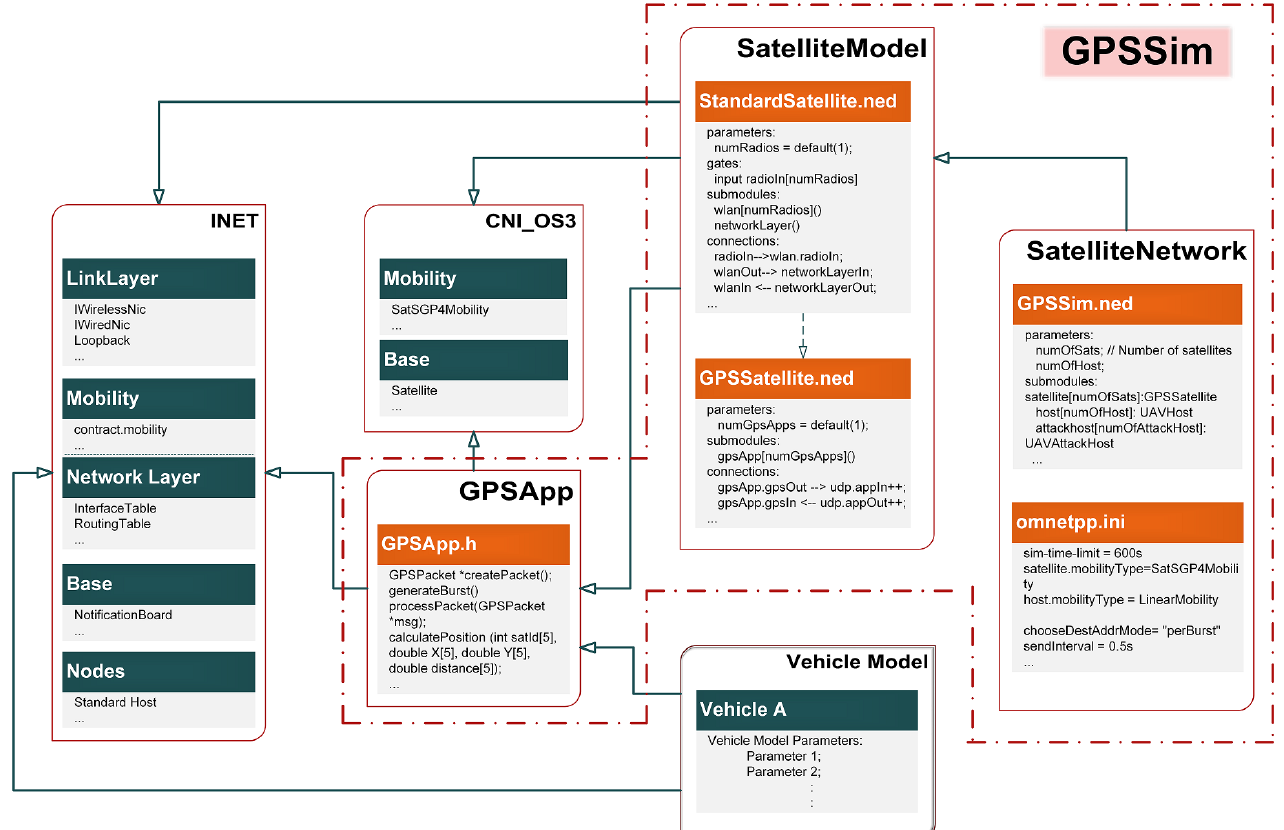
Figure 4. Architectural design of the GNSSim framework